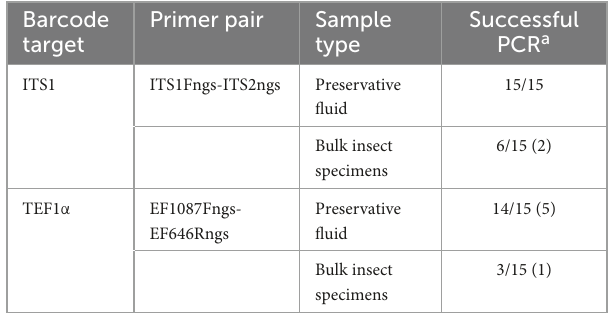
TABLE 2 PCR amplification success of preservative fluid and bulk insect specimen subsamples performed on the initial 15 trap subset sourced from Tumut, NSW (NSW1) and the